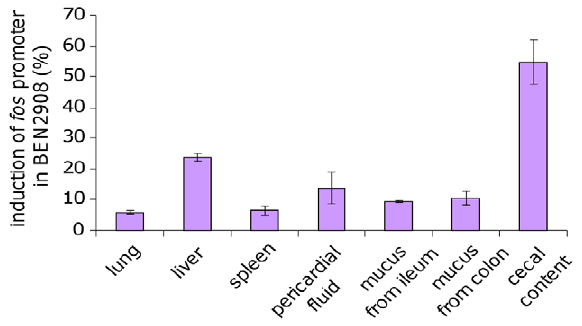
Figure 7. Activation of fos promoter in chicken extracts or physiological fluids. Percentage of fos promoter activation was obtained by dividing the maximum luciferase expression in BEN2908 by the maximum luciferase expression in BEN2908 D fosR . The average values and standard deviations result from three independent experiments.